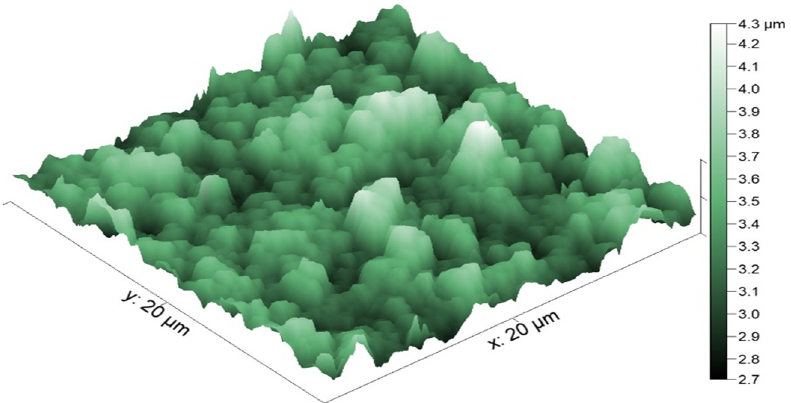
Figure 3. SPM/DFM image of as-prepared ZnO. The electrical properties of the ZnO layers were measured using a two-probe method.